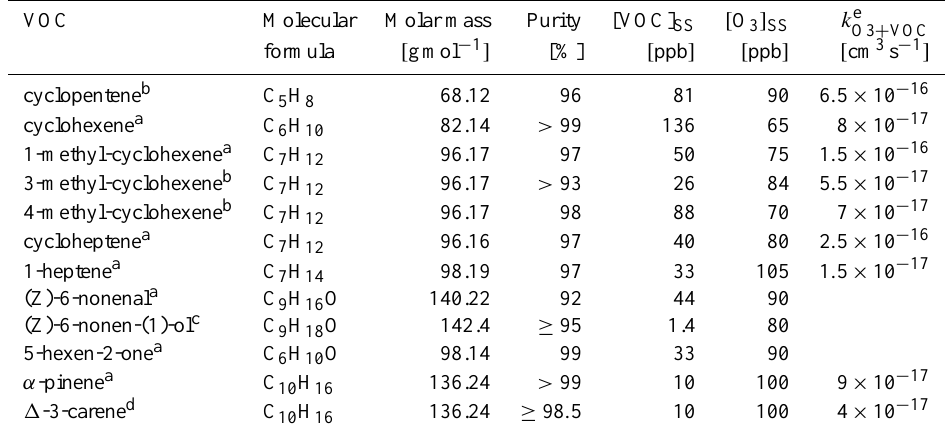
Table 1. VOC investigated in this study, steady-state mixing ratio of VOC and O 3 during the ozonolysis experiments, rate coefficient for the VOC + O 3 reactions at 298K. VOC Molecular Molar mass Purity